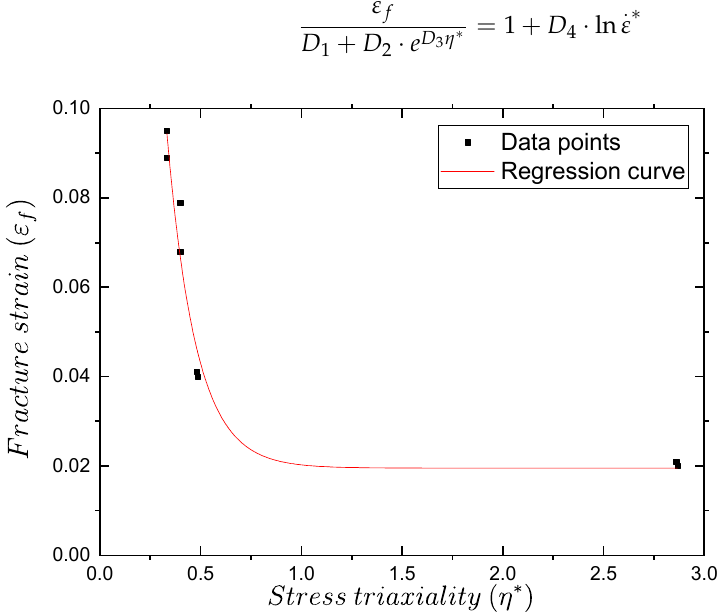
Figure 11. Fracture strain and stress triaxiality relationship from uniaxial tensile test data.